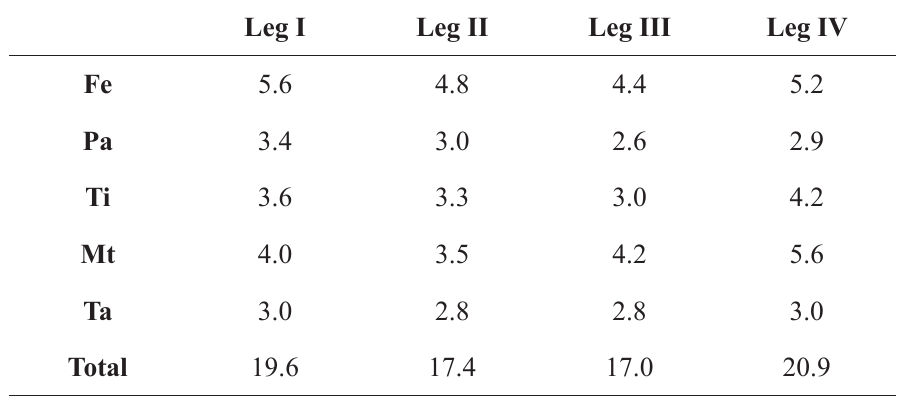
European Journal of Taxonomy 210: 1–21 Table 2. Diplura macrura (C.L. Koch, 1841), ♀. Length of left leg articles (dorsal view).